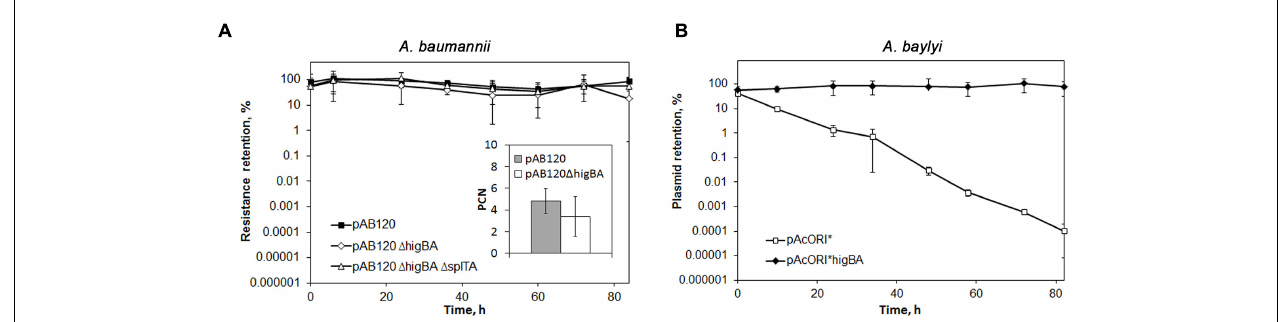
FIGURE 6 | The role of A. baumannii higBA2 Ab locus in plasmid stabilization. Bacteria containing plasmids were grown in LB without antibiotic pressure, restarting the culture every 12 h. The colony forming units (CFU) of total bacteria and antibiotic resistant bacteria was assessed by serial dilution and plating. At least three independent experiments were performed, error bars indicate standard deviation. (A) The effect of higBA2 Ab deletion on A. baumannii pAB120 plasmid maintenance and copy number. Bacteria containing pAB120 variants with or without higBA2 Ab or both higBA2 Ab and splTA Ab TA system were selected on media containing meropenem. Inside the box: plasmid copy number (PCN) of pAB120 variants with and without higBA2 Ab was calculated after 24 h growth without antibiotic pressure. PCN was calculated as described in Section “Materials and Methods”. The experiment was independently repeated 10 times, the difference of PCN between the two strains was statistically significant ( t -test, p < 0.05); (B) Effect of higBA2 Ab locus in stabilization of unstable plasmid pAcORI ∗ . Acinetobacter baylyi containing variants pAcORI ∗ with and without higBA2 Ab were selected on gentamicin (pAcORI ∗